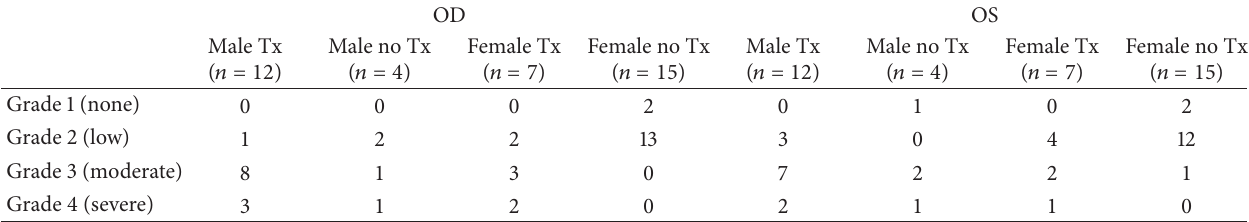
Table 2: Presence and severity of blood vessels tortuosity among group A (Fabry) subjects.